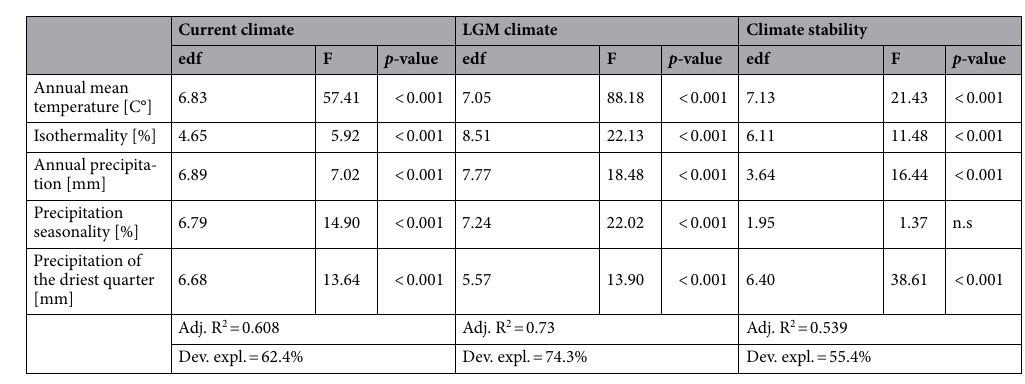
Table 1. Results of generalised additive models (GAM) of the most important climatic variables in relation to proportion of endemic plant species to overall plant species richness (PE). Three groups of climatic measures were used in three separate models: current climate, LGM climate, and climate stability (climatic change since the LGM). LGM Last Glacial Maximum in the Pleistocene, edf effective degrees of freedom, Adj. R 2 Adjusted R-squared, Dev. expl. deviance